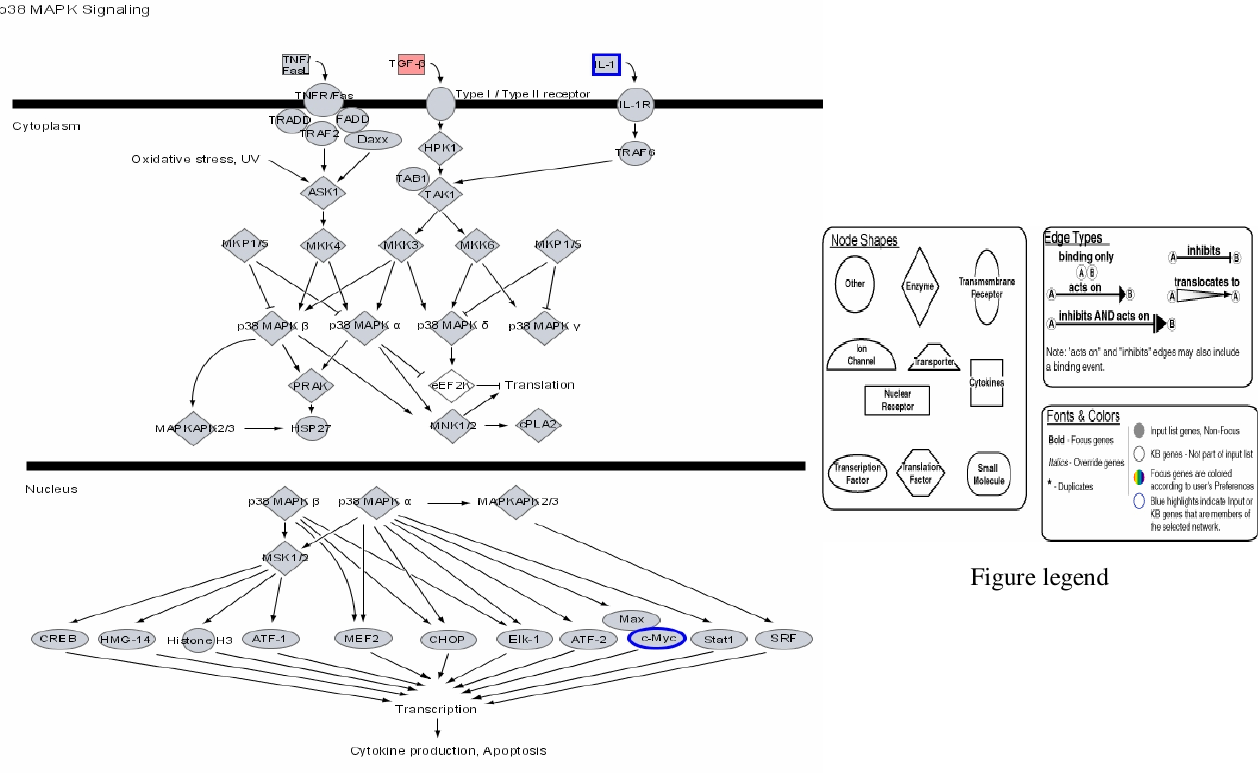
Figure 3: Modulation of P38 MAPK signalling by mercury: Activation of TGF- β and repression of IL-1 and c-Myc.